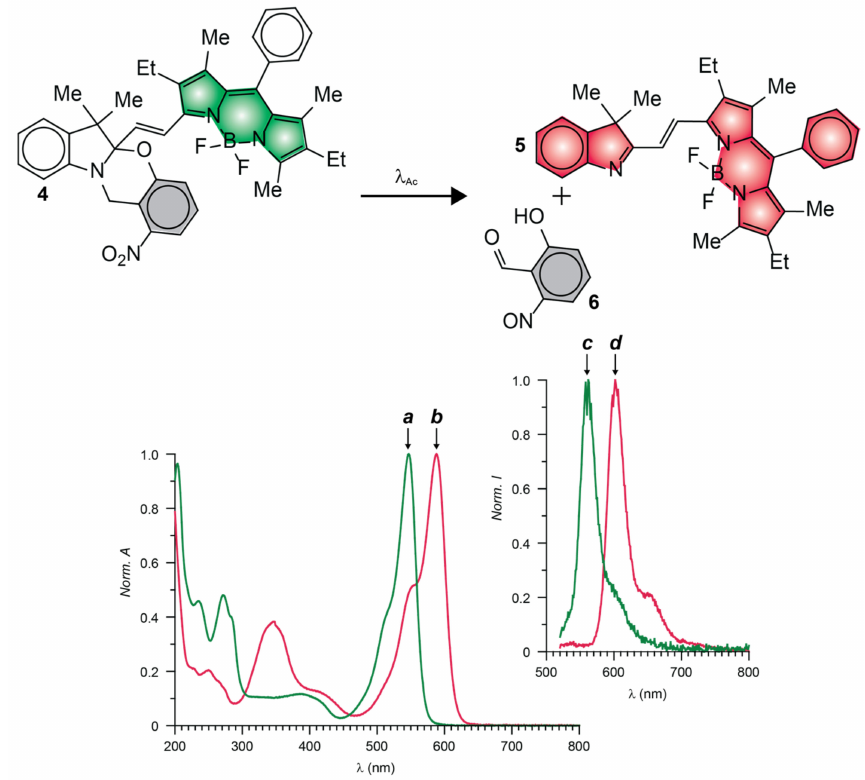
Figure 7. Normalized absorption ( a,b ) and emission (( c , d ), λ Ex = 480 nm) spectra of 4 (green traces) and 5 (red traces) in MeCN at 25 ◦